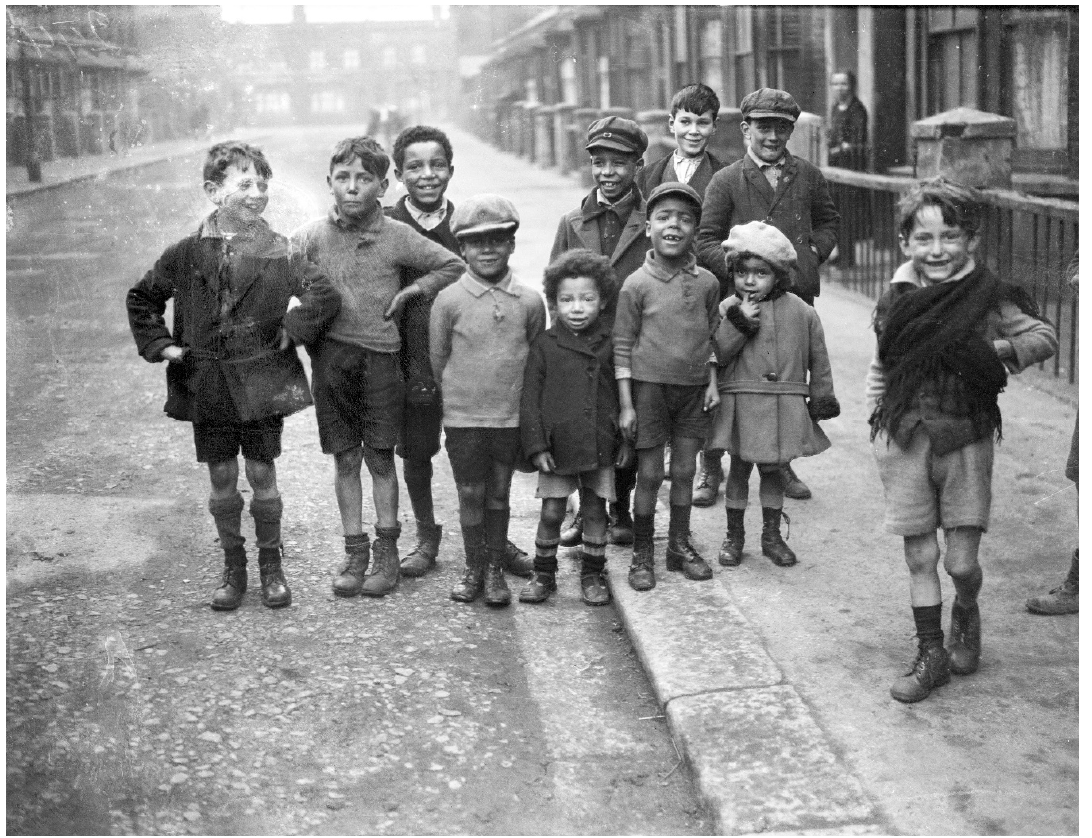
Figure 1. Crown Street Children, circa 1930. © Mary Evans Picture Library.